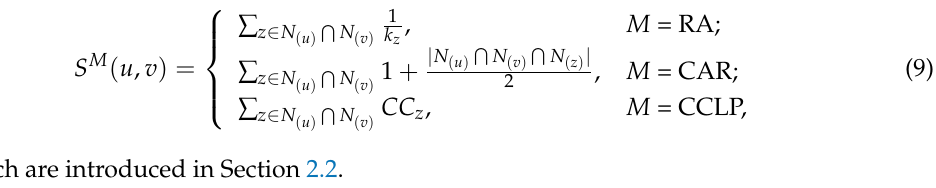
Algorithm 1 HS-GCN embedding